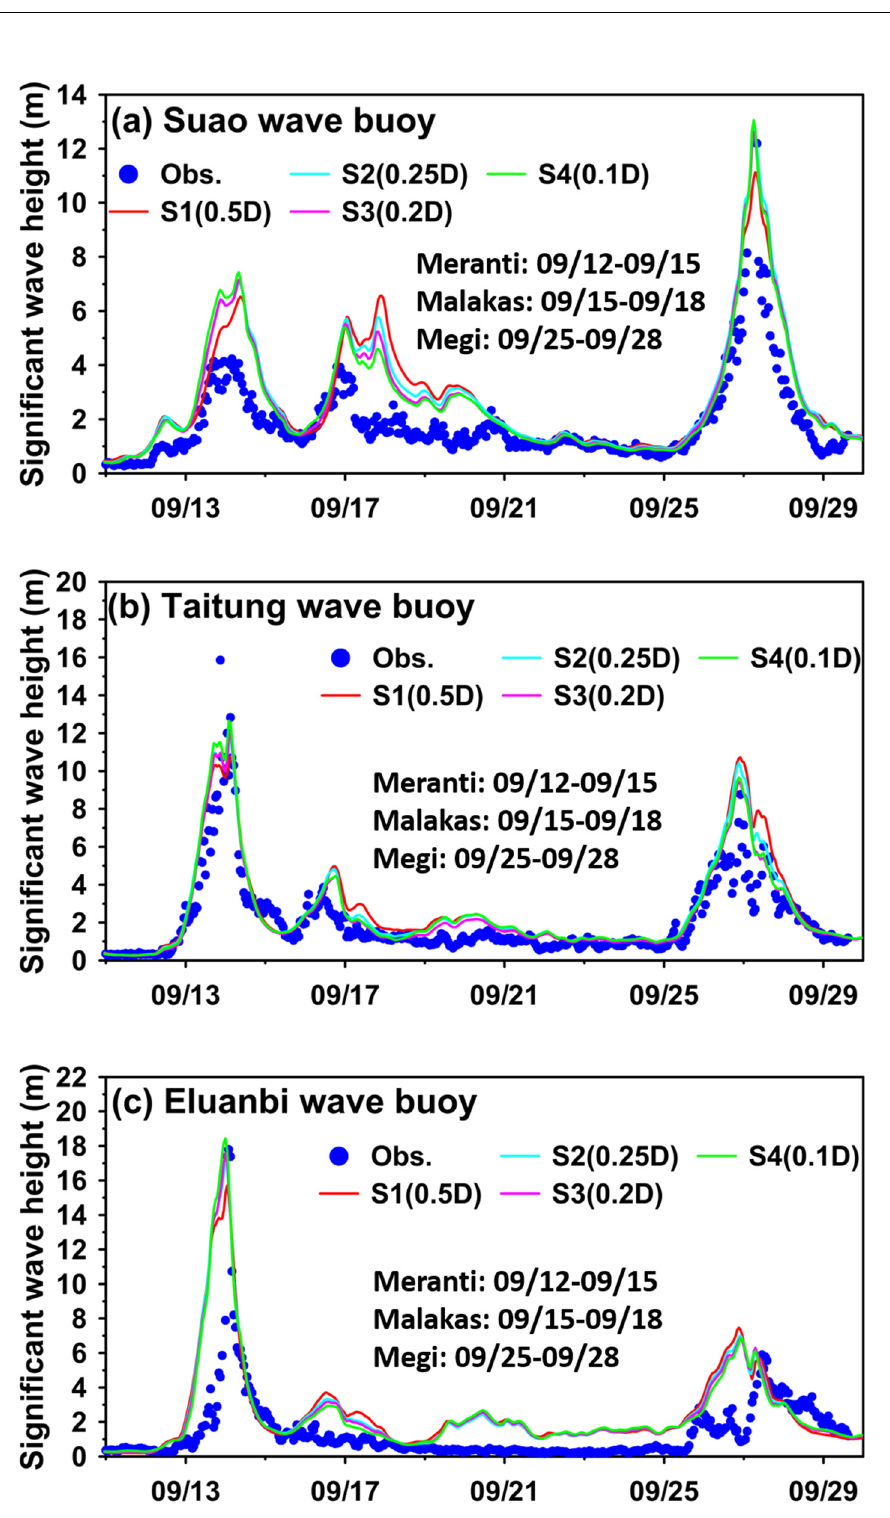
Figure 10. Comparison of the hourly significant wave heights between simulations with different grid resolutions and measurements for the ( a ) Suao, ( b ) Taitung, and ( c ) Eluanbi wave buoys in September 2016.